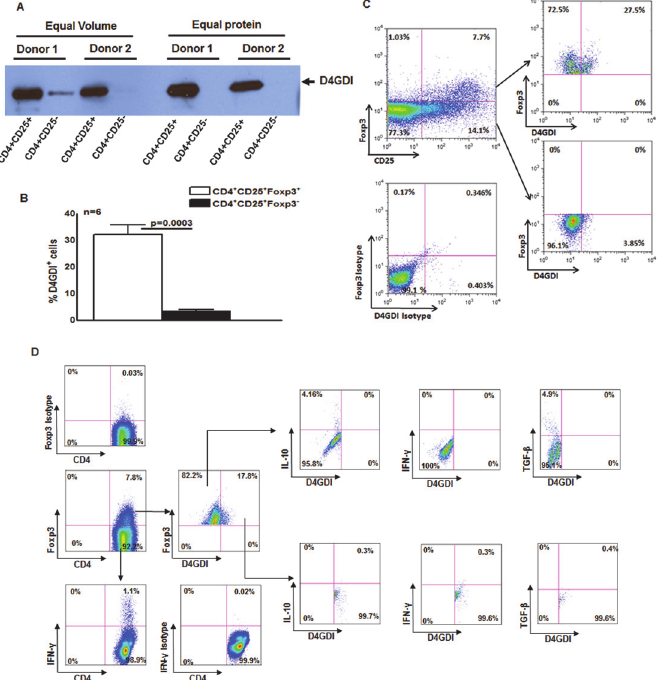
Figure 2. A subset of Foxp3 + cells express D4GDI. (A) CD4 + cells from PBMC of 6 donors with LTBI were cultured with autologous monocytes and γ -irradiated M. tb (10 μ g/ml). After 4 days, CD4 + CD25 + (85 – 90% Foxp3 + ) and CD4 + CD25 - ( < 5% Foxp3 + ) cells were isolated, and cultured overnight in serum-free medium. Culture supernatants were subjected to Western blotting with anti-D4GDI. Data from 2 individuals with LTBI are shown. (B) CD4 + cells and autologous monocytes from 6 donors were cultured as in panel A. After 4 days, the percentages of D4GDI + cells in CD4 + Foxp3 + and CD4 + Foxp3 ‑ cells were determined by flow cytometry. Mean values, p values and SEs are shown. (C) A representative flow cytometry plot is shown. (D) PBMC from 5 individuals with LTBI were cultured with γ -irradiated M. tb H37Rv. After 4 days, the percentages ofCD4+Foxp3+D4GDI+IFN- γ +, CD4+Foxp3+D4GDI+IL-10+ and CD4+ Foxp3+D4GDI+TGF- β + cells were determined by flow cytometry. A representative flow cytometry plot is